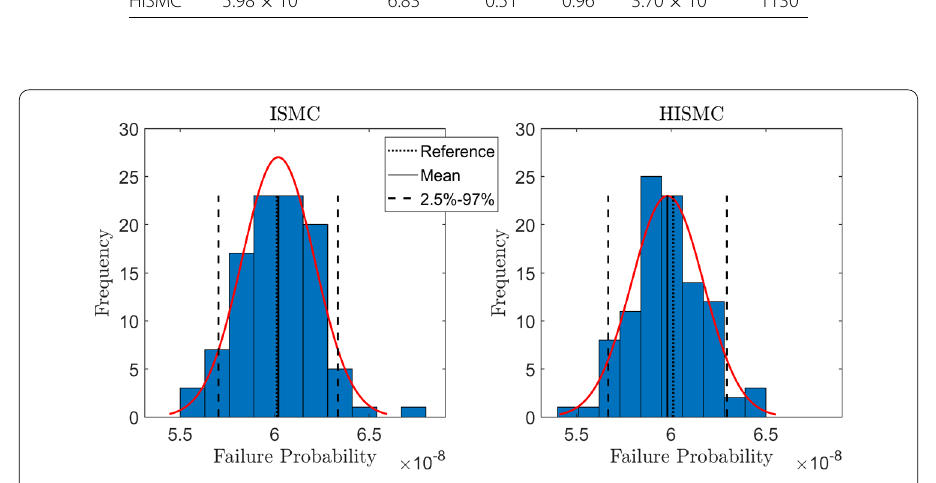
Figure 6 Memory cell: probability distributions of ISMC and HISMC methods from N rep = 100 experiments with mean 6.02 × 10 –8 and 5.98 × 10 –8 ,